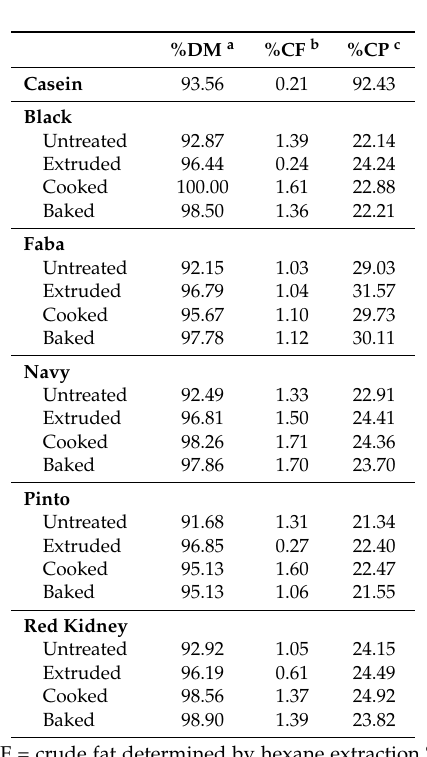
Table 1. Proximate analysis of untreated, extruded, cooked and baked beans presented on a dry matter